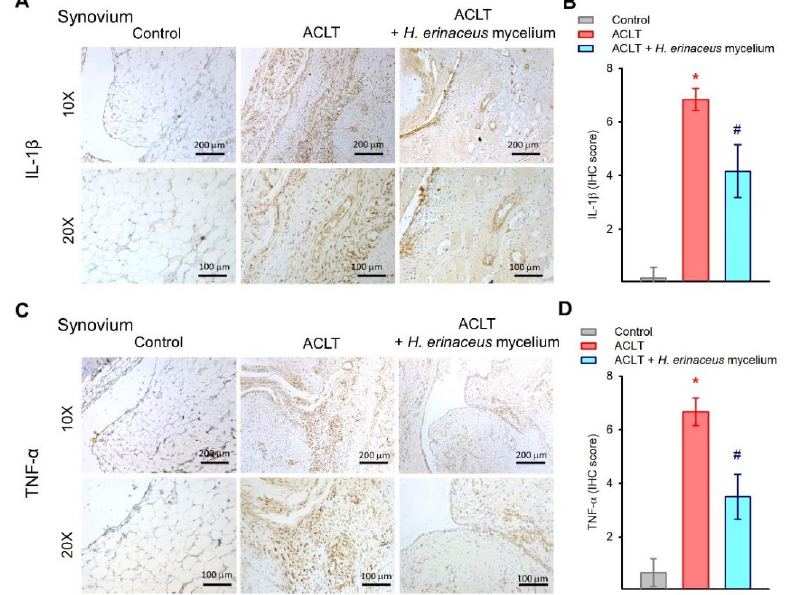
Figure 6. H. erinaceus mycelium inhibits IL- 1β and TNF - α expression in synovial tissue. ( A , C ) Rep- resentative images of IL- 1β and TNF - α staining. ( B , D ) Quantification of IHC scores ( n = 6 for each group). * p < 0.05 compared to the control group; # p < 0.05 compared to the ACLT-only